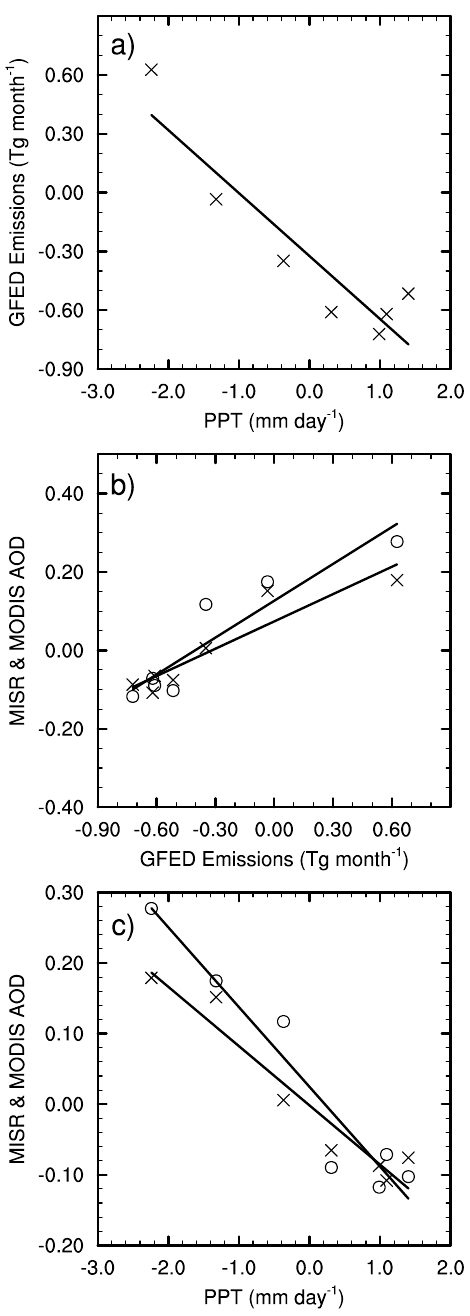
Fig. 2. Causal links between drought and aerosol optical depth in equatorial Asia during 2000–2006. (a) The relationship between GPCP precipitation anomalies and GFED fire emissions anomalies in equatorial Asia (90 ◦ E–120 ◦ , 5 ◦ S–5 ◦ N) for the three-month fire season (August–October) during 2000–2006. (b) Same as (a) but for GFEDv2 emissions and either MISR (x) or MODIS (o) AOD anomalies. (c) Same as (b) but for GPCP precipitation anomalies and either MISR (x) and MODIS (o) AOD anomalies. Drought trig- gers increases in fire emissions that in turn increases aerosol loading in the atmosphere as observed by MISR and